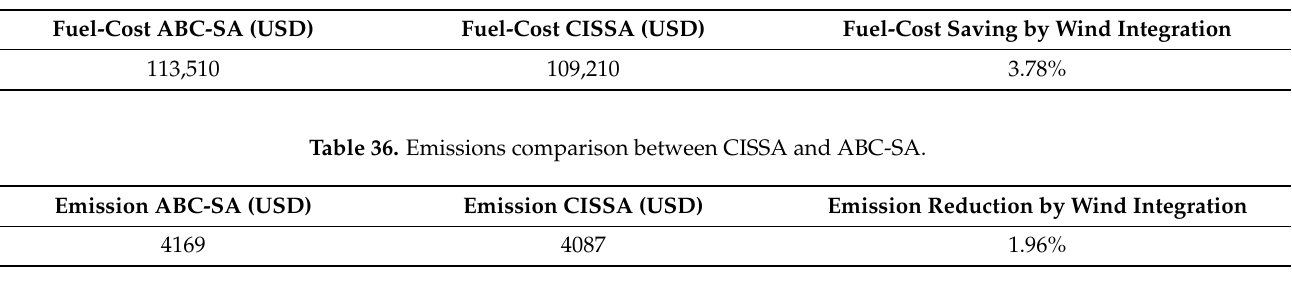
Table 35. Fuel-cost comparison between CISSA and ABC-SA.